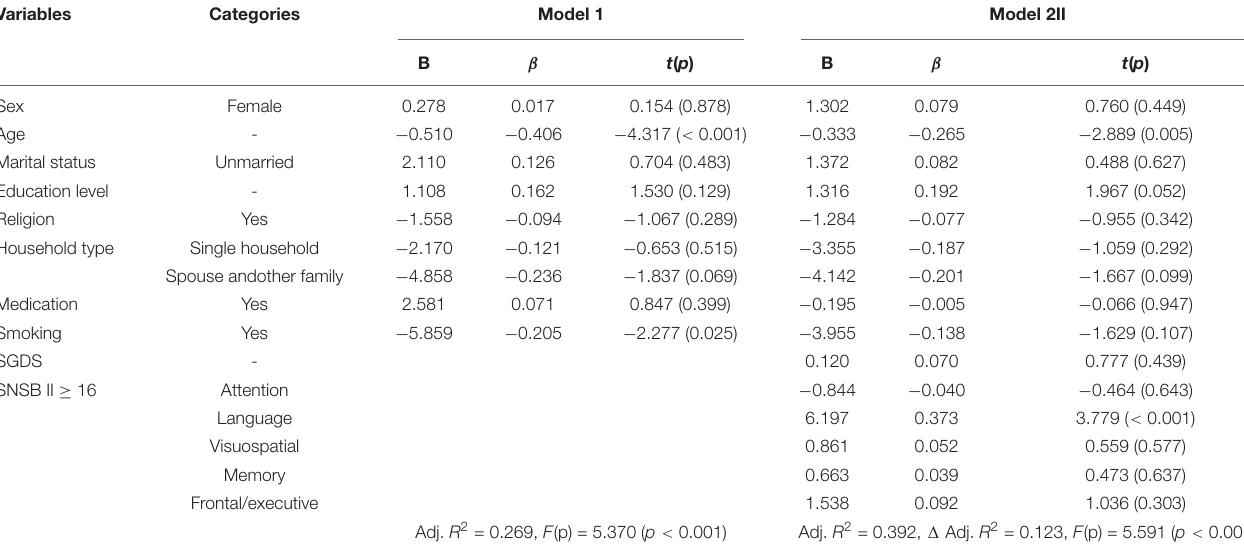
TABLE 5 | Factors affecting olfactory